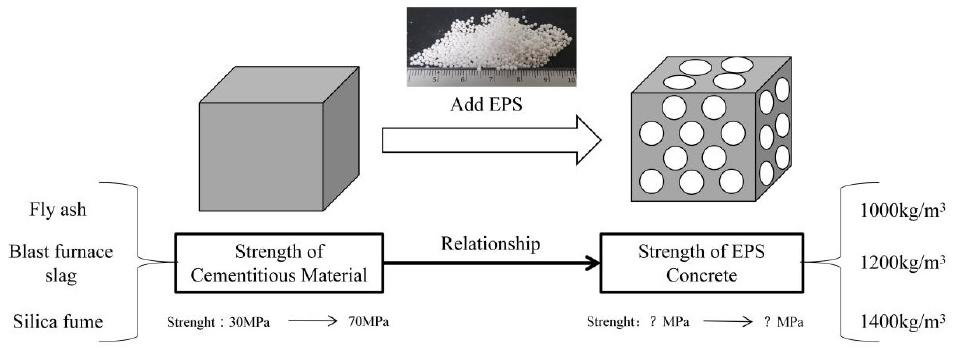
Figure 1. Experimental method.